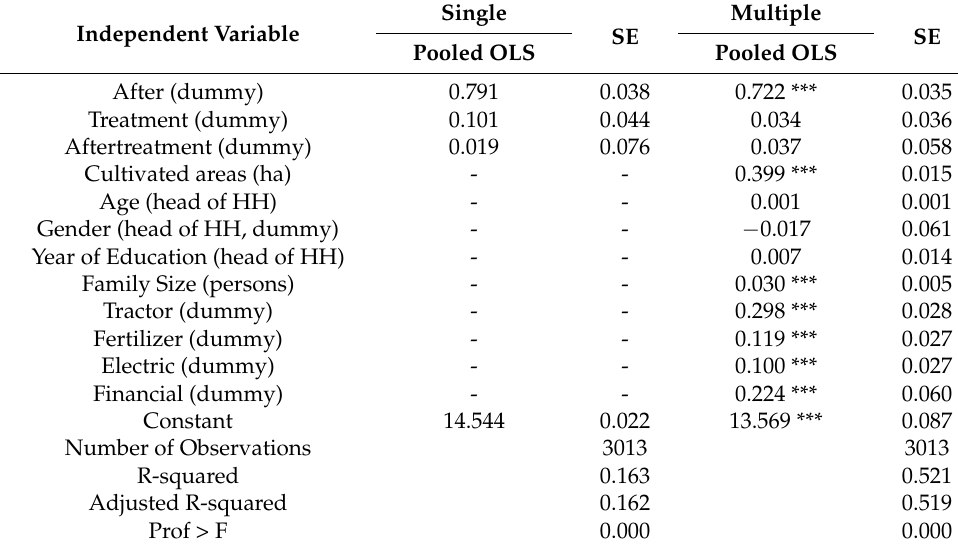
Table 5. The DID estimated by pooling the OLS of the impact of irrigation on log rice farm income with and without control variables.